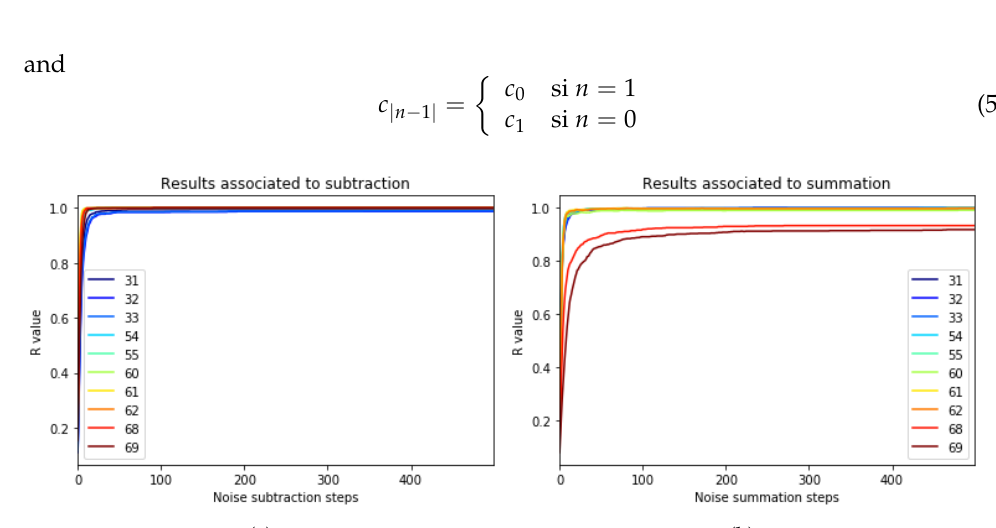
Figure 7. The monitoring of ( a ) R ( k , m sub , c 1 ) and ( b ) R ( k , m sum , c 1 ) during the noise addition process.